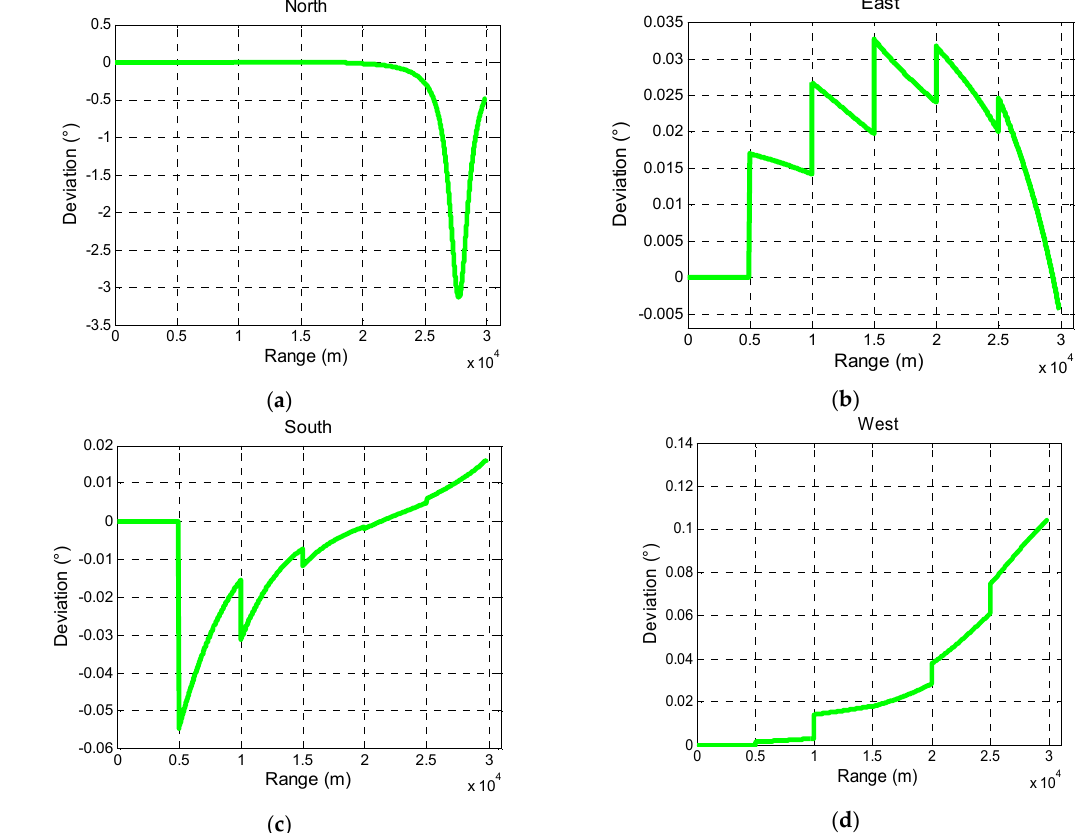
Figure 15. Deviation of compensation angle caused by different geomagnetic information in north direction ( a ), east ( b ) direction, south ( c ) direction, and west ( d ) direction.